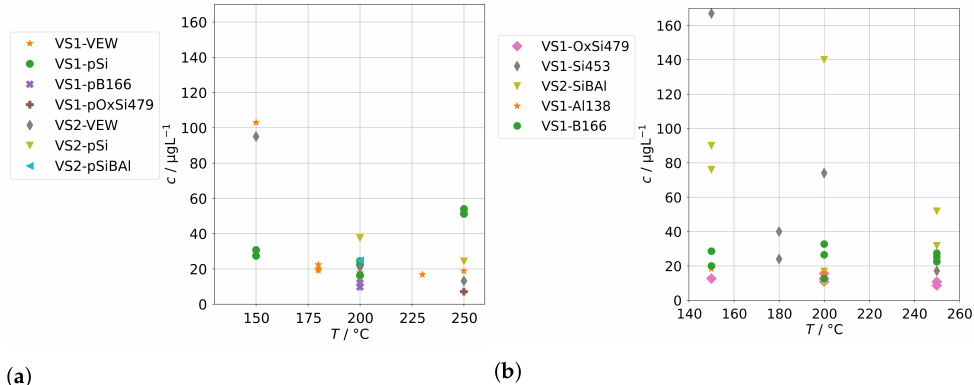
Figure 2. Sodium concentrations in condensates in dependence of operation temperature for the two SB-SG: ( a ) Background levels for clean feed-waters; ( b ) Concentrations for spiked feed-water solutions containing